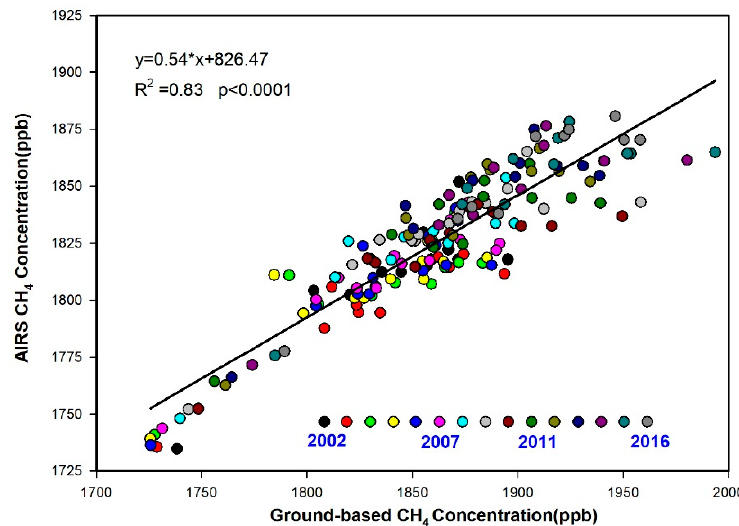
Figure 2. Scatter plots of the annual averaged ground-based CH 4 concentrations, and AIRS retrievals for nine sites during 2002 to for nine sites during 2002 to 2016.